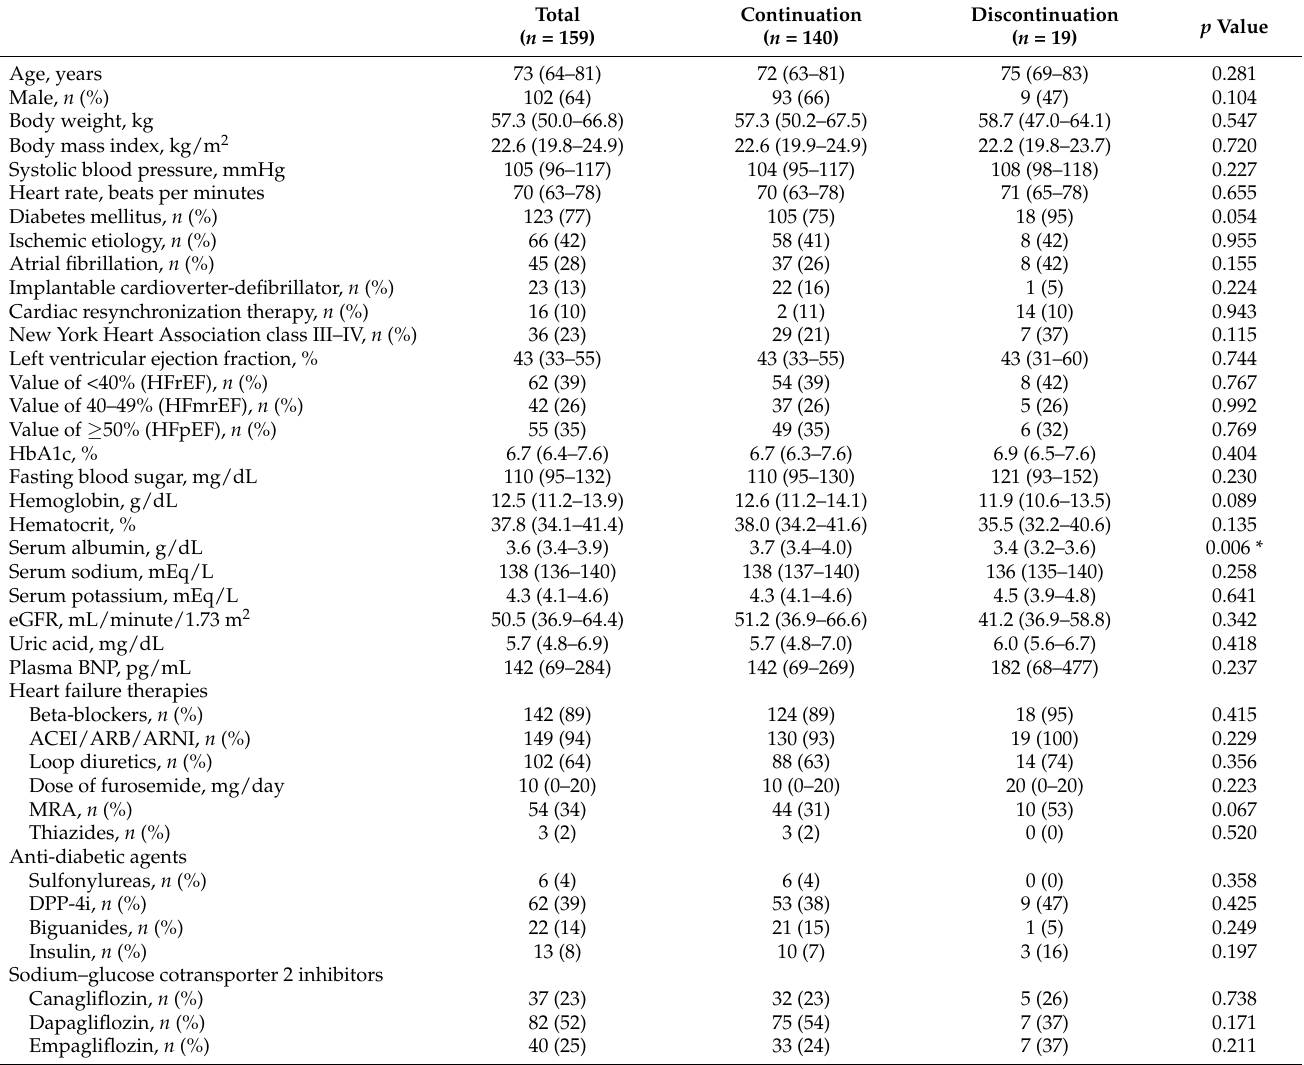
Table 1. Baseline characteristics at index